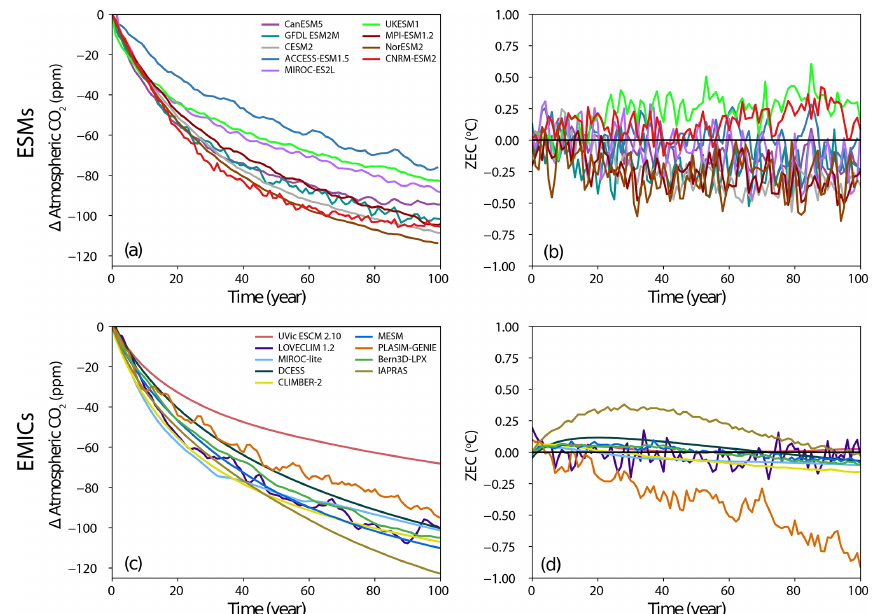
Figure 2. (a, c) Atmospheric CO 2 concentration anomaly and (b, d) Zero Emissions Commitment following the cessation of emissions during the experiment wherein 1000PgC was emitted following the 1% experiment (A1). ZEC is the temperature anomaly relative to the estimated temperature at the year of cessation. The top row shows the output for ESMs, and the bottom row shows the output for EMICs.